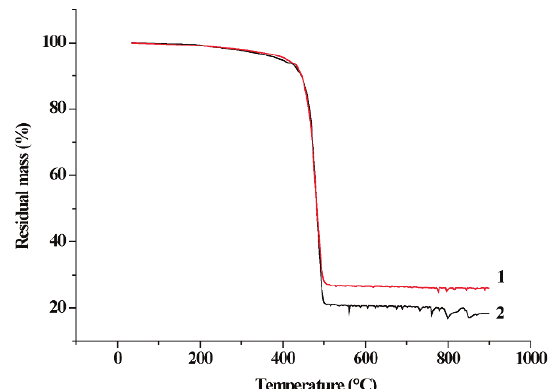
Figure 4. SEM analysis of the burn-out LLDPE with 20% EG and 10% APP (I) as flame retardants.